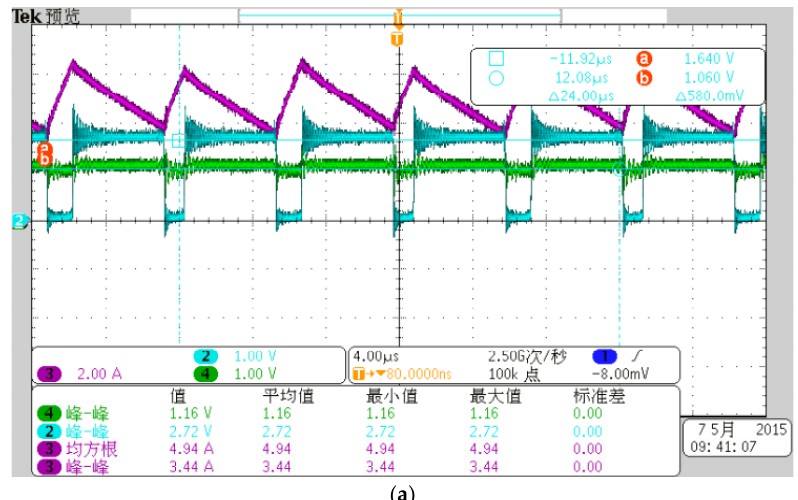
Figure 16. Cont. Figure 16. Cont.